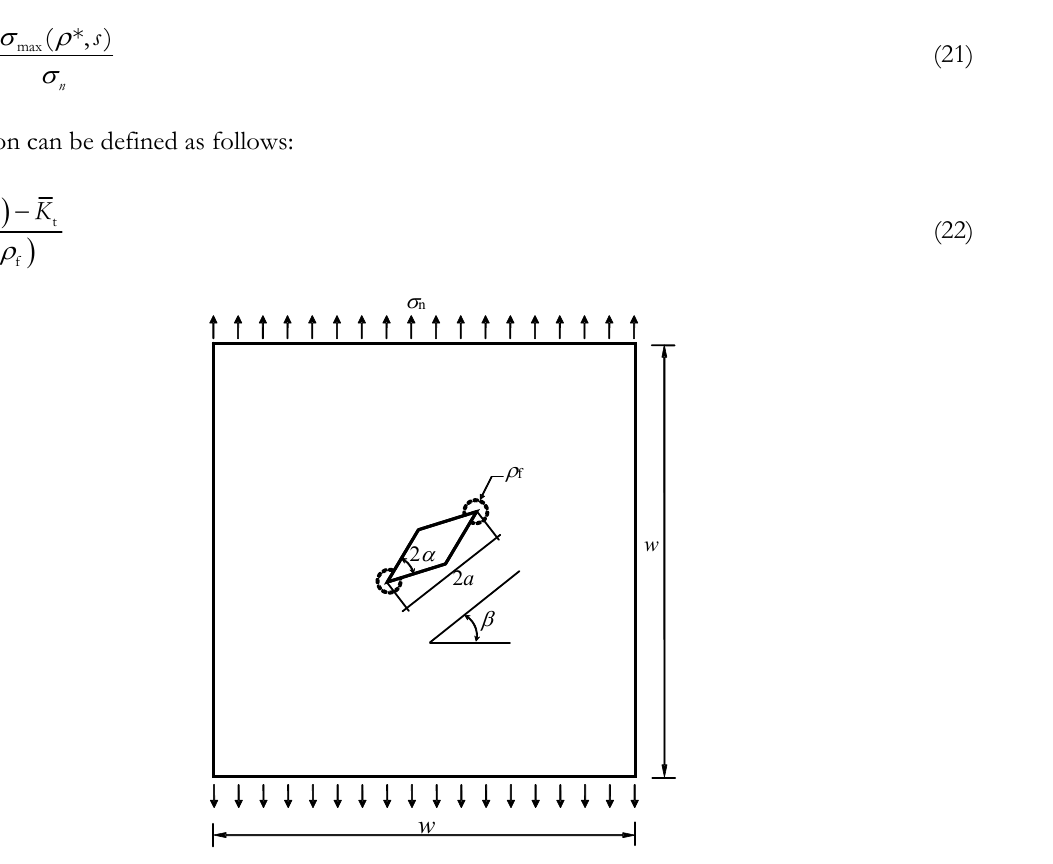
Figure 3: Geometry and dimensions of the double-V-notched quadratic plate specimen considered in the FE analyses; remote loading by prescribed nominal stress  n ; dimensions w = 100 mm and 2 a = 14.14 mm; real pointed versus fictitiously rounded (root hole) V- notch.